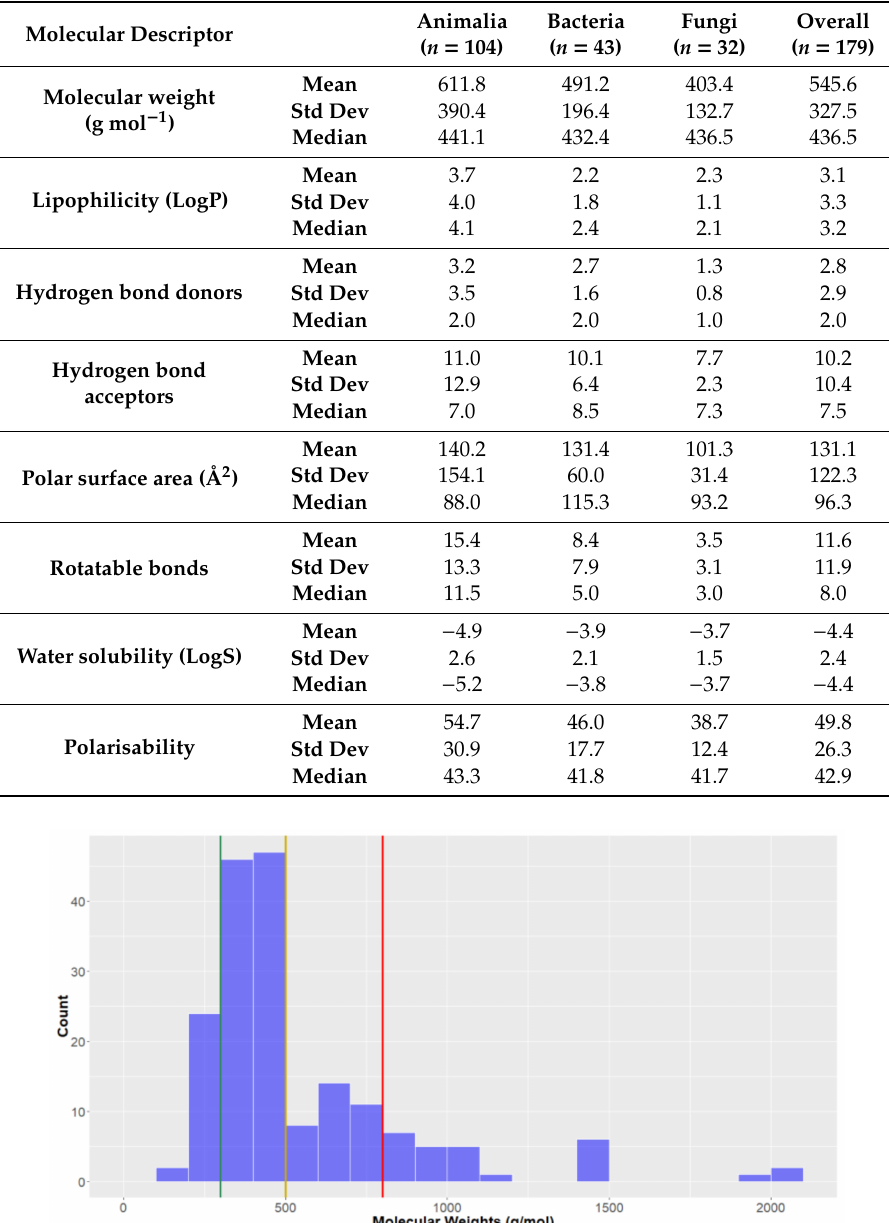
Table 2. Mean, standard deviation (std dev) and median values of the compound types for the eight molecular descriptors analysed in this study.